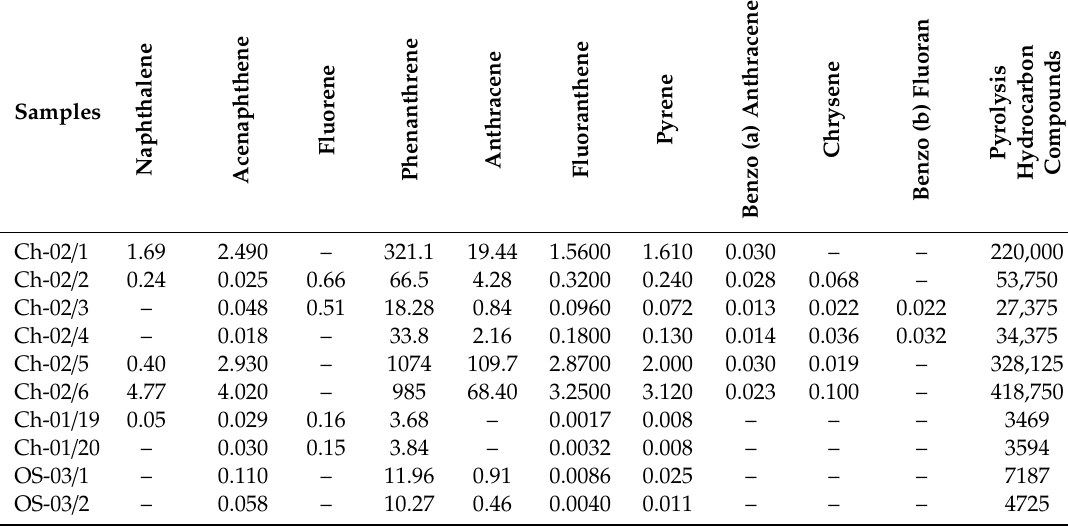
Table 2. Polycyclic aromatic hydrocarbon content (mg /